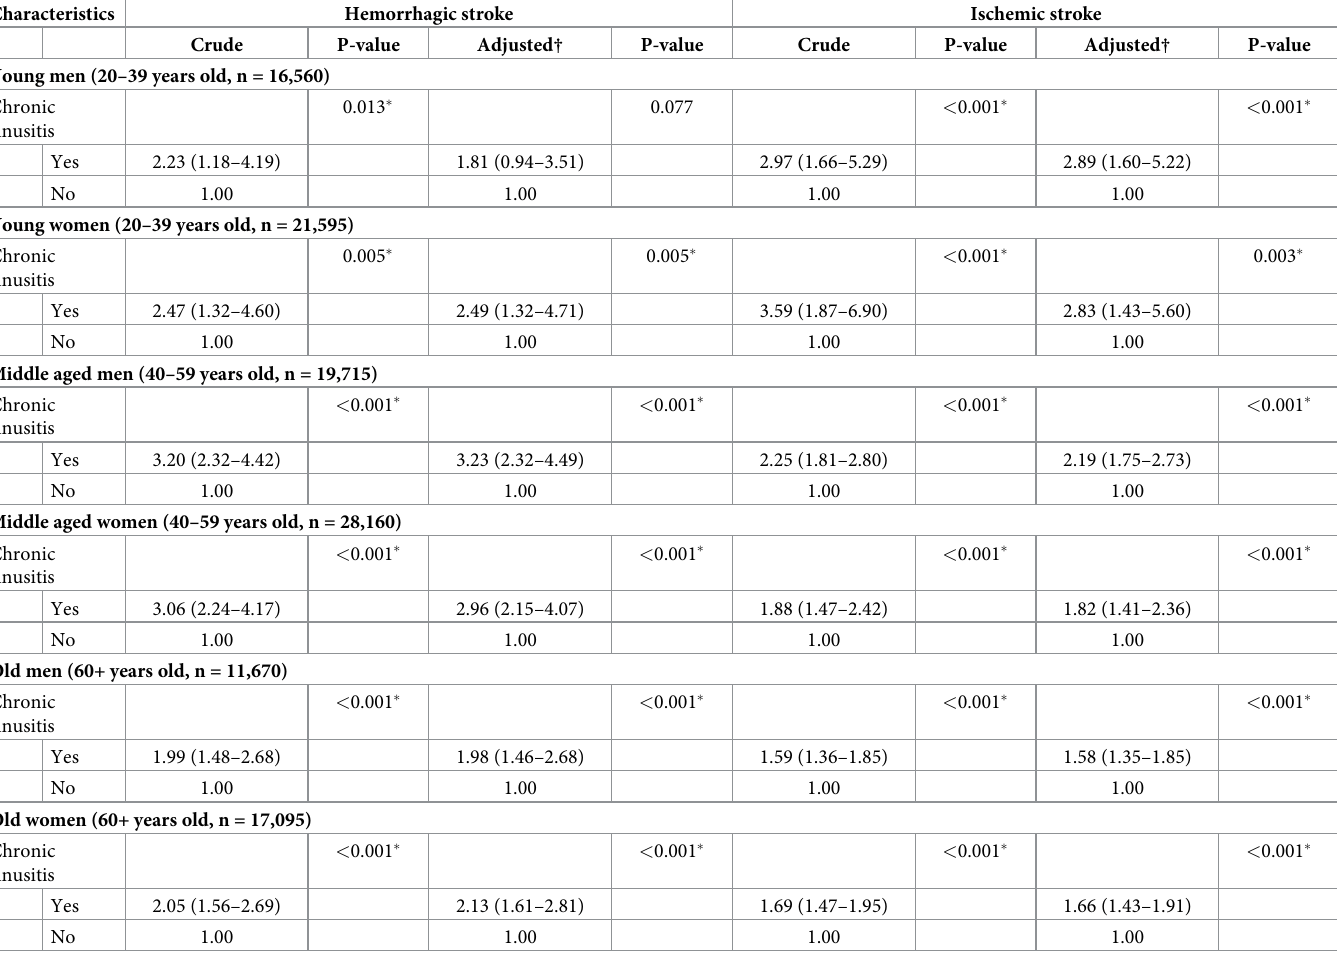
Table 3. Subgroup analysis of crude and adjusted hazard ratios (95% confidence interval) of chronic sinusitis for hemorrhagic stroke and ischemic stroke according to age and sex.